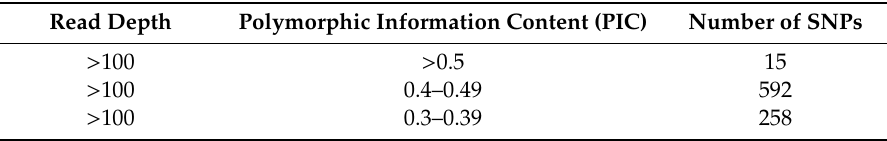
Table 3. Summary of SNPs identified from the OLin tetraploid reference method.